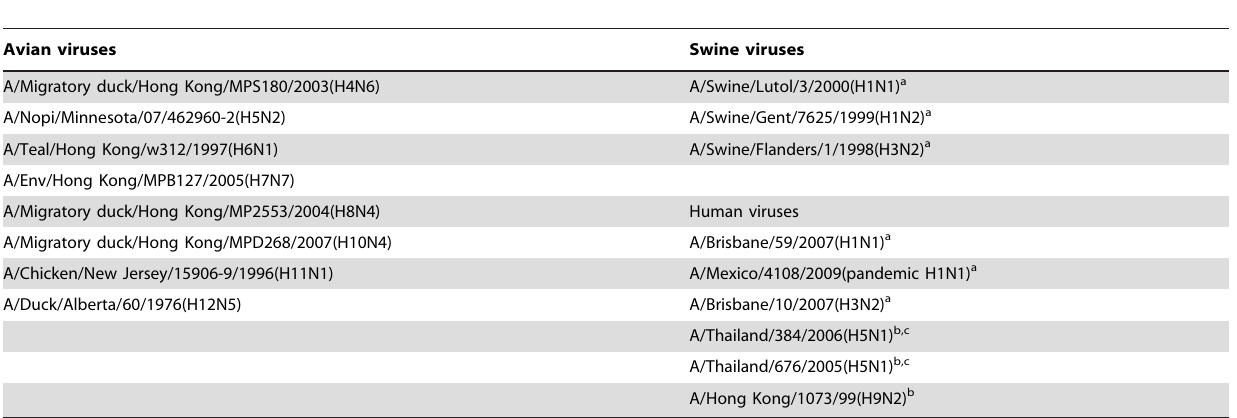
Table 1. Viruses used in serological studies. Unless otherwise indicated serologic study was performed using the microneutralization